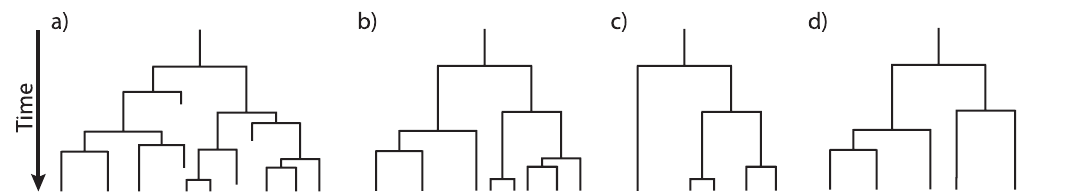
Figure 1. Sketches of a tree produced by a birth-death process. The process starts with a single lineage at the origin. At each speciation event the ancestral lineage is replaced by two descendant lineages. At an extinction event the lineage simply terminates. a) A complete tree including the extinct lineages. b) The reconstructed tree of tree a) without the extinct lineages. c) A randomly sampled tree of the same reconstructed tree. Every taxa had the same probability r to be sampled. d) A five-taxon tree where taxa are selected to maximize diversity (diversified